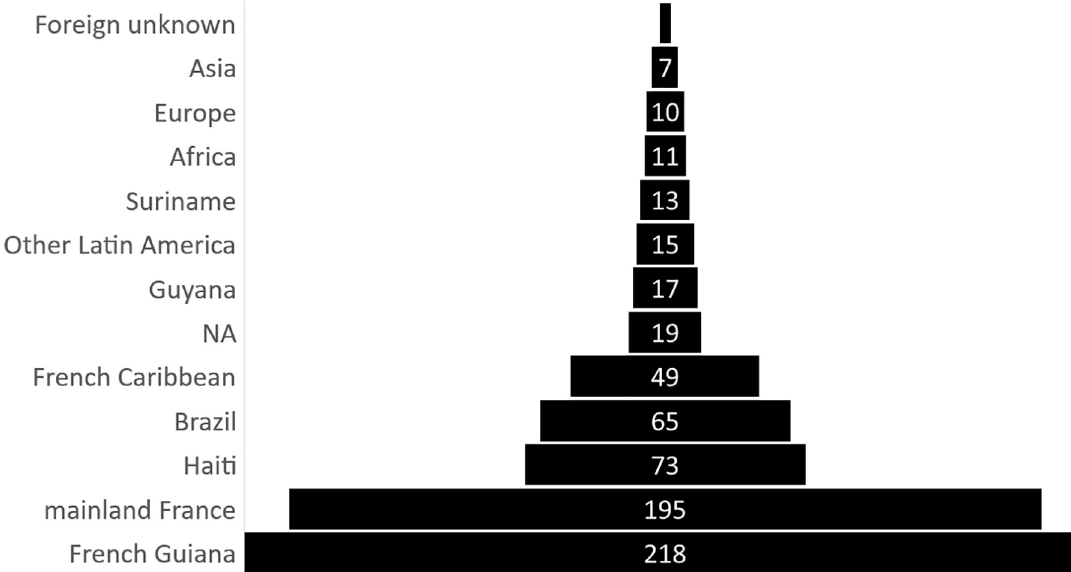
Fig 3. Country or territory of birth of patients infected by Q fever 2007–2017. NA: Country of birth unknown; Foreign unknown: not born in France, nor French Guiana or French Caribbean, but information of foreign country not available.